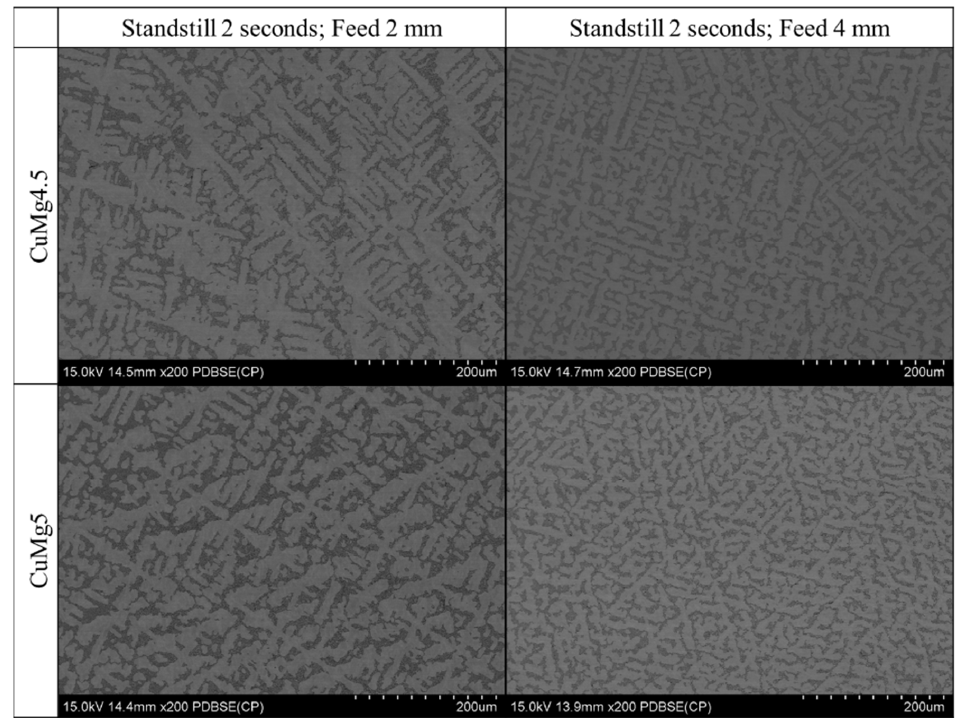
Figure 7. Backscatter electron SEM analysis of CuMg alloys in the as-cast state (200× magnification).